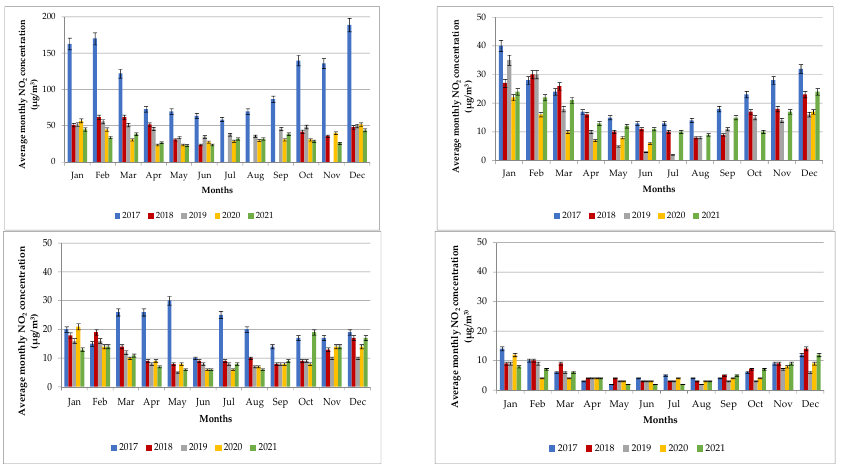
Figure 4. Average monthly NO 2 concentrations at locations A, B, D, and E between 2017 and 2021 (from left to right, from top to bottom). Figure 5 shows average annual NO 2 concentrations at studied locations between 2017 and 2021. Average annual NO 2 concentrations were the highest at location A (50.00 ± 2.50 µ g/m 3 ) in 2017, while the lowest were detected at location E (5.00 ± 0.25 µ g/m 3 ) in 2019, 2020, and 2021.